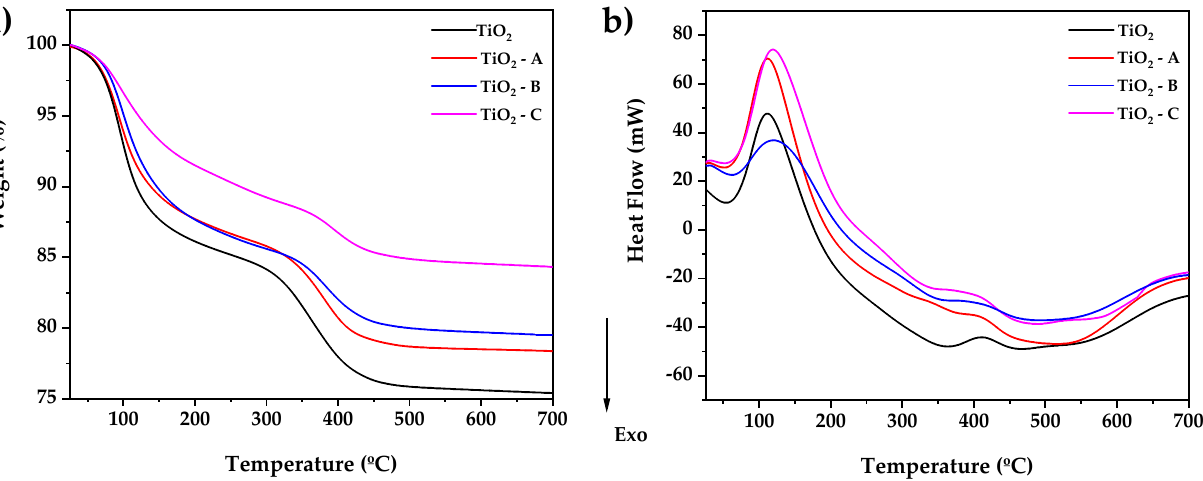
Figure 1. ( a ) Thermogravimetric analysis and ( b ) scanning differential calorimetry of dried pure and doped TiO 2 samples .